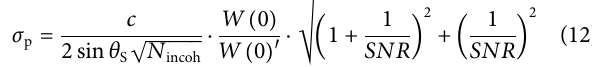
Frontiers in Earth Science |